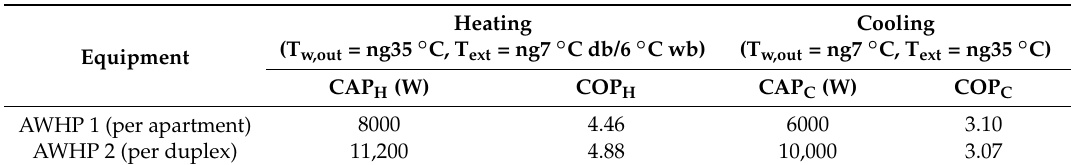
Table 4. System B nominal